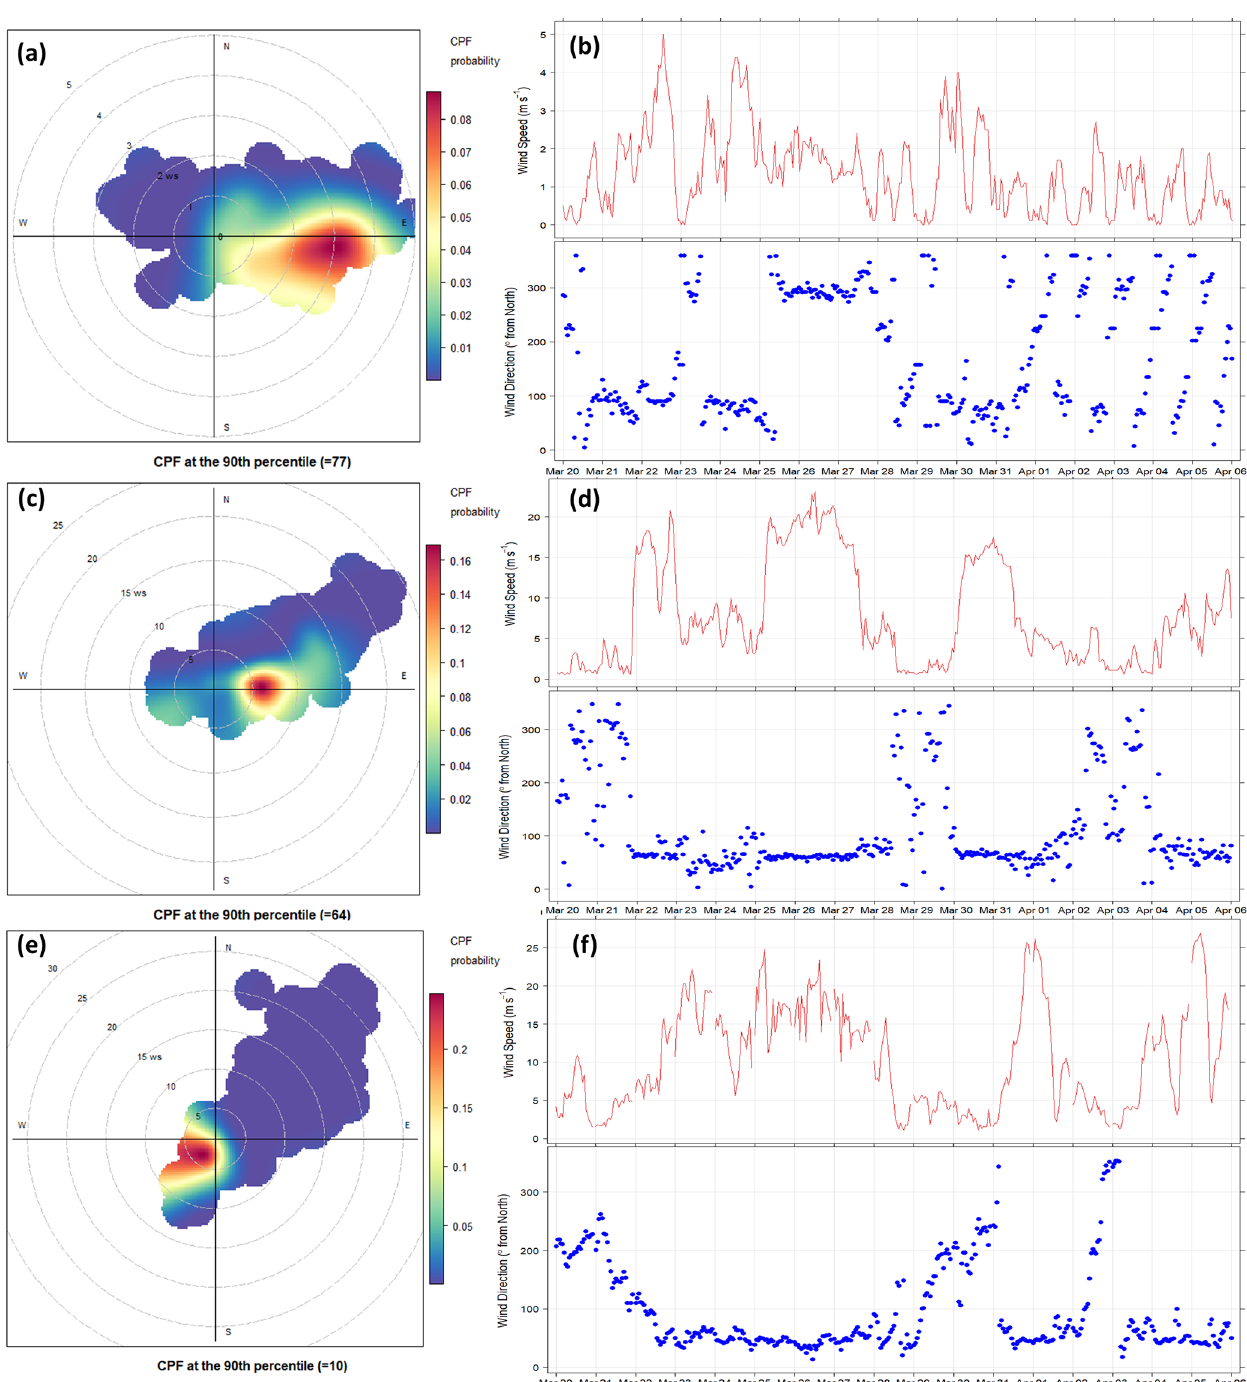
Figure 5. Polar plots of (a) fr5 for Bologna, (c) fr5 for Trieste, and (e) fr3 for Mt. Cimone; the gray dashed circumferences indicate wind speed in meters per second (ms − 1 ). The wind speed (red line) and wind direction (blue points) from 20 March to 6 April 2020 for (b) Bologna, (d) Trieste, and (f) Mt. Cimone are also shown.